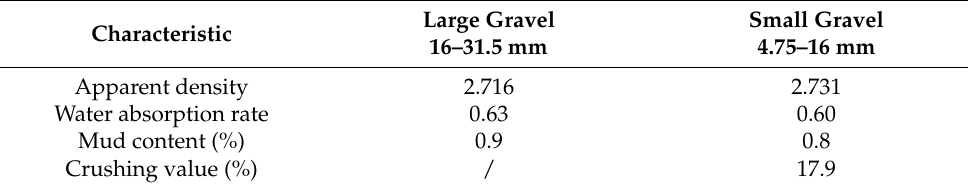
Table 1. Basic properties of coarse